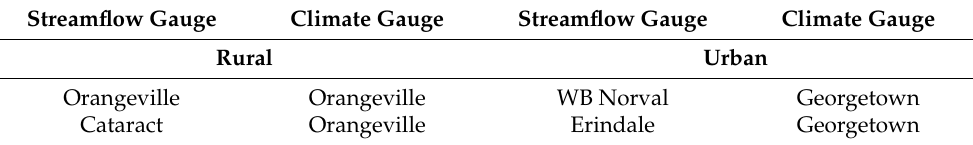
Table 1. Concomitant streamflow and climate gauges selected for the present study.